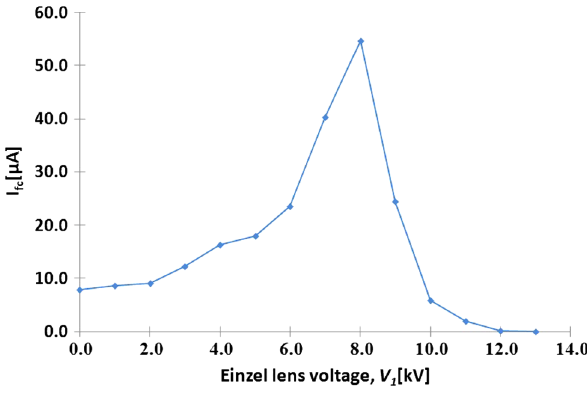
FIG. 8. Dependence of the He 1 þ beam currents on V 1 as simulated with IGUN and the transfer matrix method.